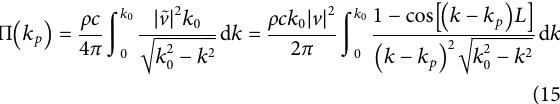
FIGURE 2 System ’ s geometry on the y − z